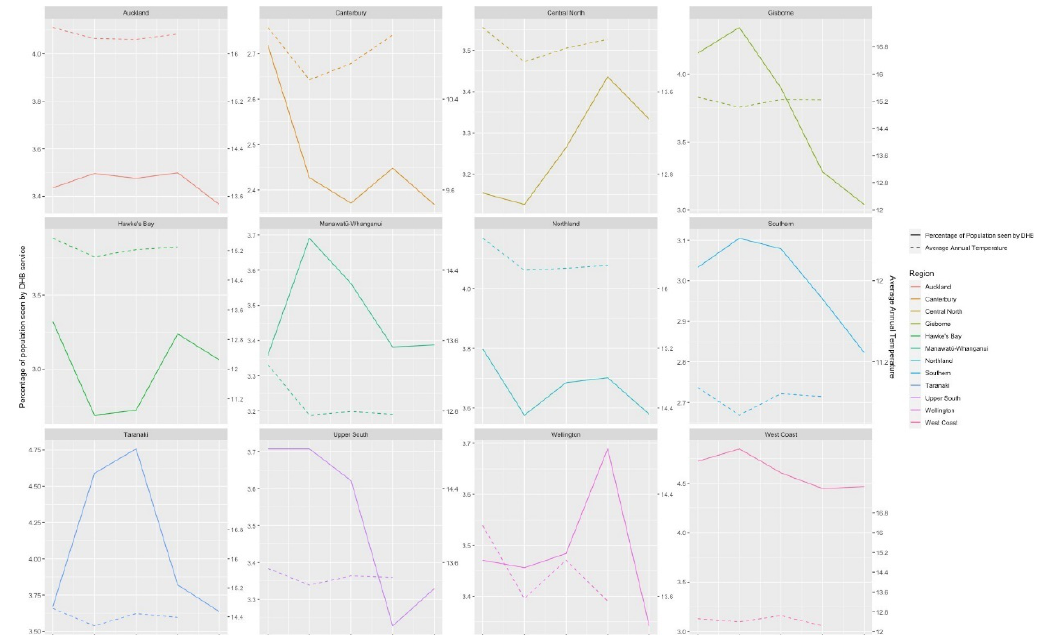
Figure 6 Regional facet chart of average temperature compared to the rate of the population seen by